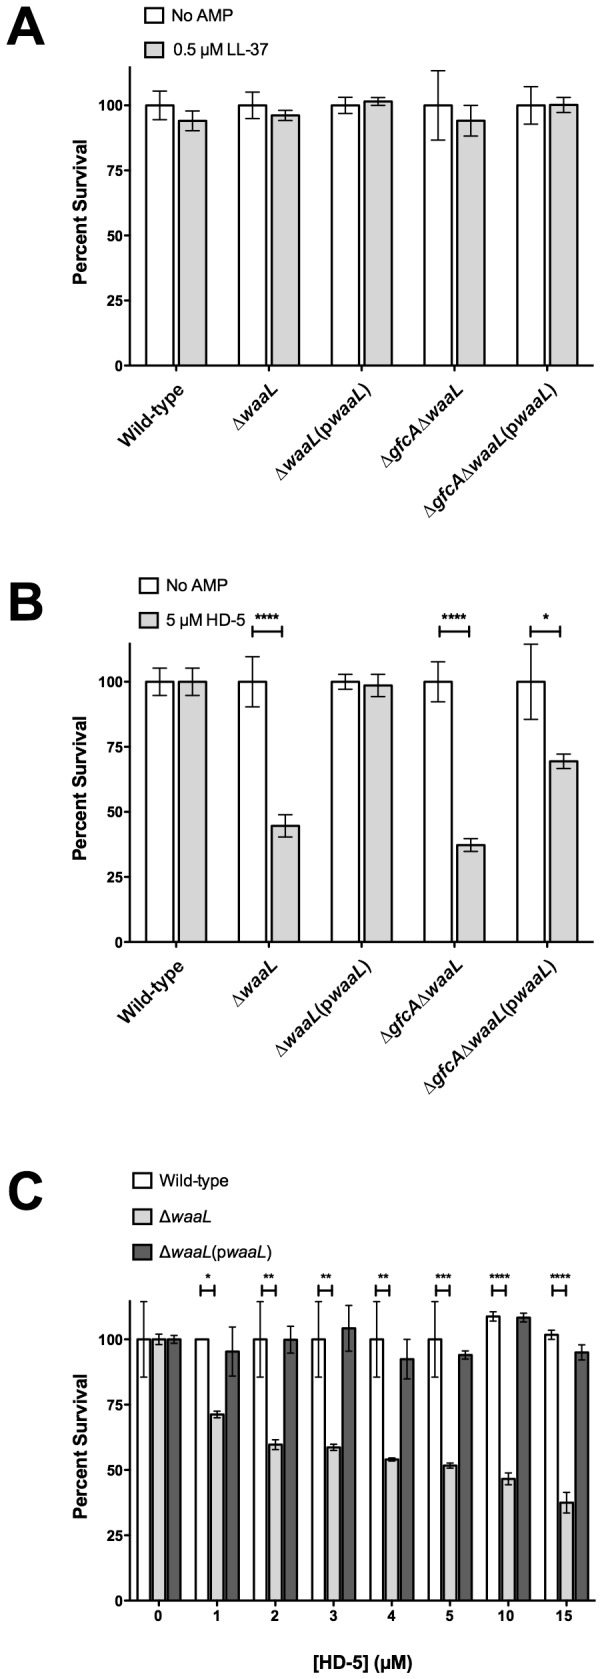
The O-antigen promotes resistance to HD-5.Survival of the indicated EPEC strains in the presence of LL-37 (A) and HD-5 (B and C) at the indicated concentrations. Results are expressed as means ± SEs of triplicate samples. Data shown are representative of at least three independent experiments. Asterisks indicate statistical significance; *, P<0.05; **, P<0.01; ***, P<0.001; ****, P <0.0001 by two-way ANOVA and Bonferroni’s multiple comparison post
hoc test.